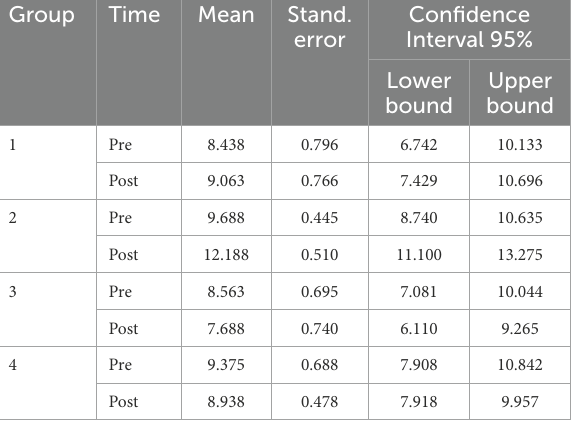
TABLE 12 Fear of medical pain means by comparing groups and time. Group